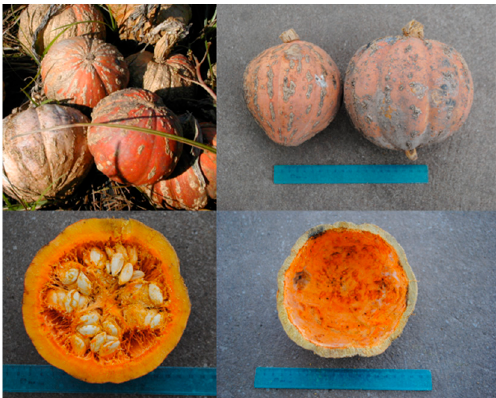
Figure 12. Fruits of Zipinka cultivar ‐ group. Lower row, left , sliced mature fruit; right , seeds and flesh were removed to show thick rind. Blue ruler length 20 cm.